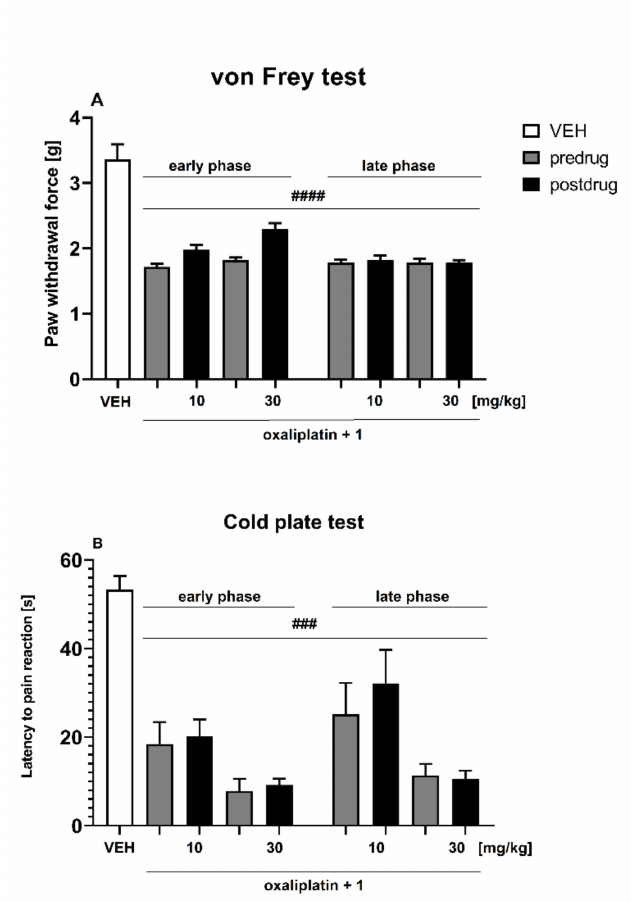
Figure 7. Effect of 1 (doses: 10 and 30 mg/kg i.p.) on pain threshold in oxaliplatin-induced neu- ropathic pain model measured using the von Frey test ( A ) and the cold plate test ( B ) in the early phase (3 h after oxaliplatin injection) and in the late phase (7 days after oxaliplatin injection) of neuropathy. Results are shown as the mean ( ± SEM) force applied to elicit paw withdrawal ( A ), or the mean ( ± SEM) latency to pain reaction ( B ). Statistical analysis: repeated measures ANOVA, followed by Tukey’s post hoc comparison. Significance vs. non-neuropathic, vehicle-treated mice (VEH): ### p < 0.001, #### p < 0.0001. In the VEH group, measurements of pain sensitivity threshold were taken in the same manner and at the same time points as in oxaliplatin-treated groups but vehicle-treated mice were not treated with